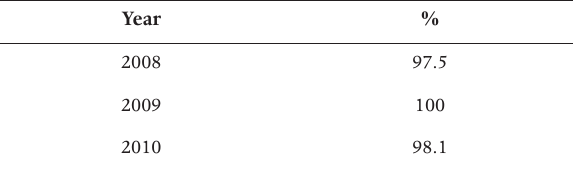
Table 1. Percentage of days of available ISACCO-DMC0 data.